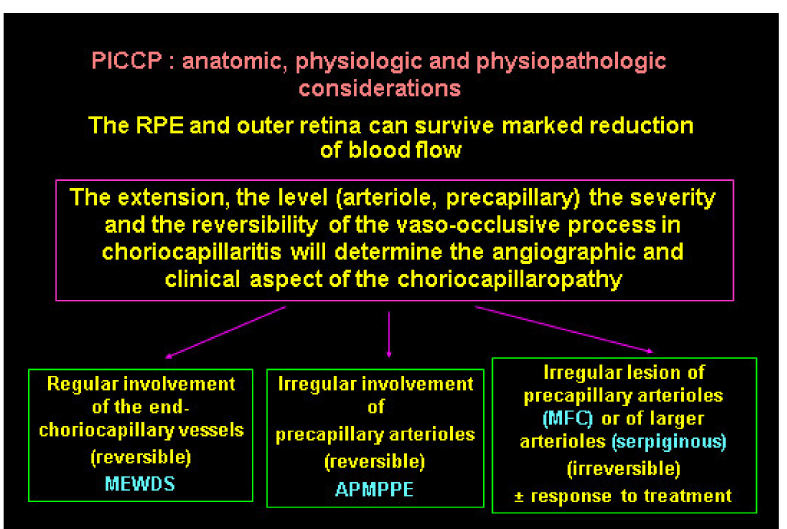
Figure 27. Clinicopathology hypothesis for the PICCPs. Type and extent of vascular involvement determine the clinical